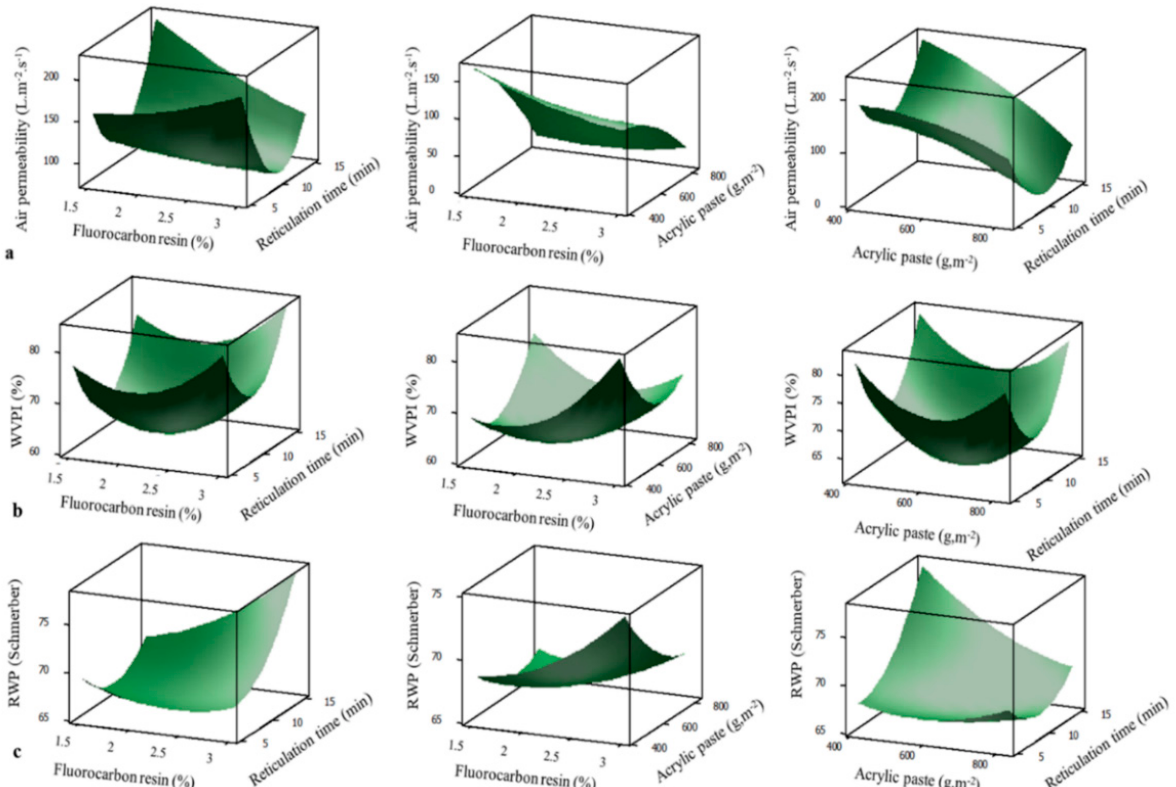
Figure 3. 3D surface plots of the studied responses: ( a ) air permeability (L·m − 2 ·s − 1 ); ( b ) WVPI (%); and ( c ) RWP (Schmerber). (Hold values: fluorocarbon resin: 2.25%, acrylic paste: 618 g·m − 2 , and reticulation time: 10 min.)